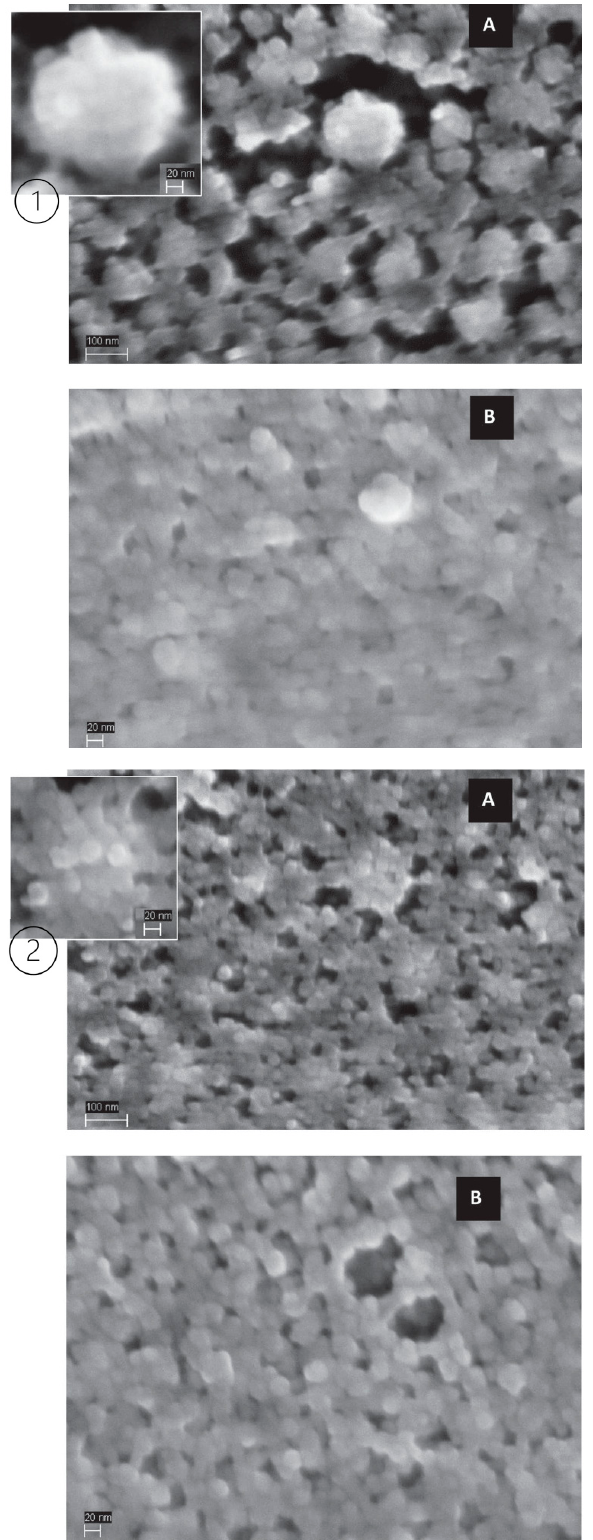
Figure 5. SEM images of 10% micellar casein concentrates ( 1 ) and 10% milk protein concentrates ( 2 ). Untreated samples ( A ) and 450-MPa-treated samples ( B ) [52]. Reproduced with